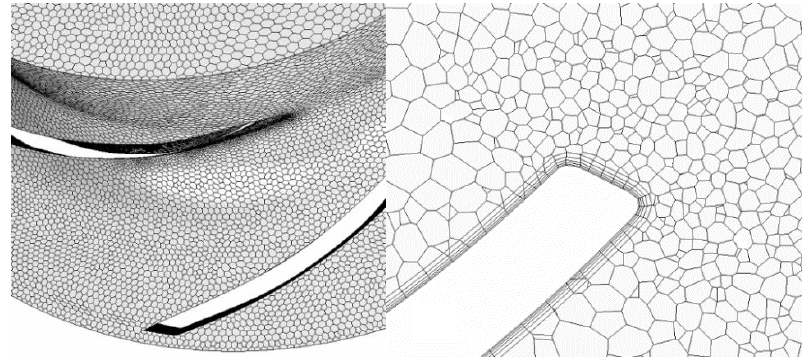
Figure 3. Parts of computational grid.